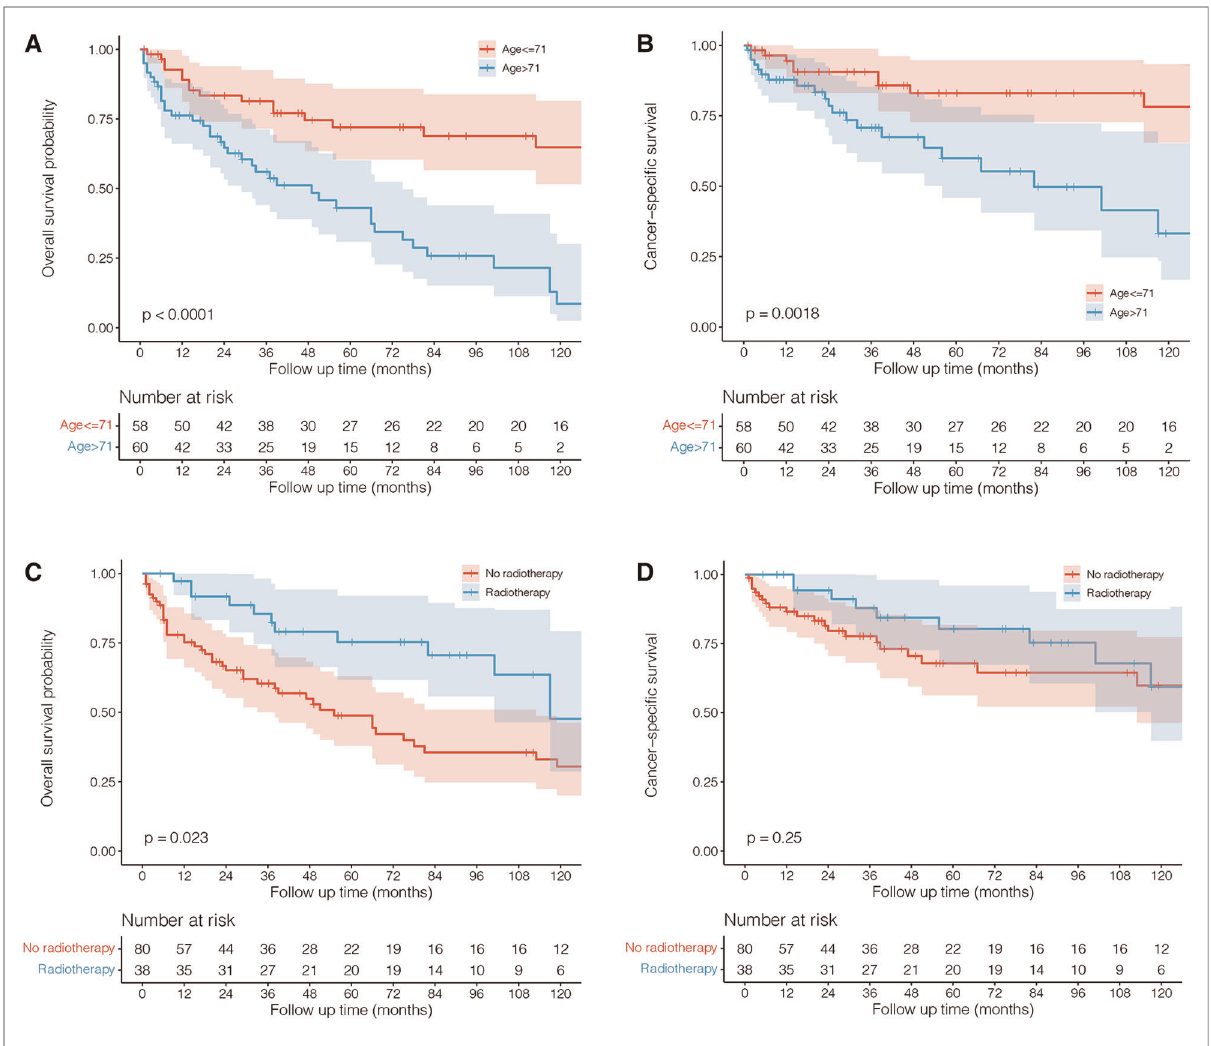
FIGURE 3 Death causes of male and female patients with primary breast lymphoma. HL, Hodgkin ’ s lymphoma; NHL, non-Hodgkin ’ s lymphoma.